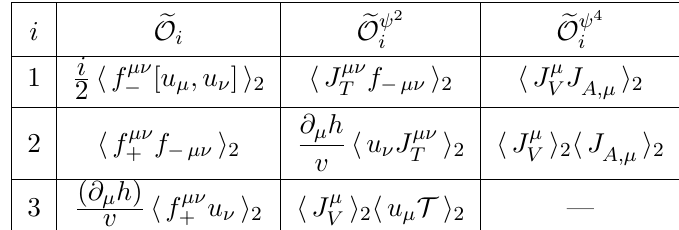
Table 1 . CP -invariant and P -even operators of the O ( p 4 ) EWET Lagrangian. The left column shows bosonic, the central two-fermion, and the right column four-fermion operators. All Wilson coe(cid:14)cients are Higgs-dependent functions.